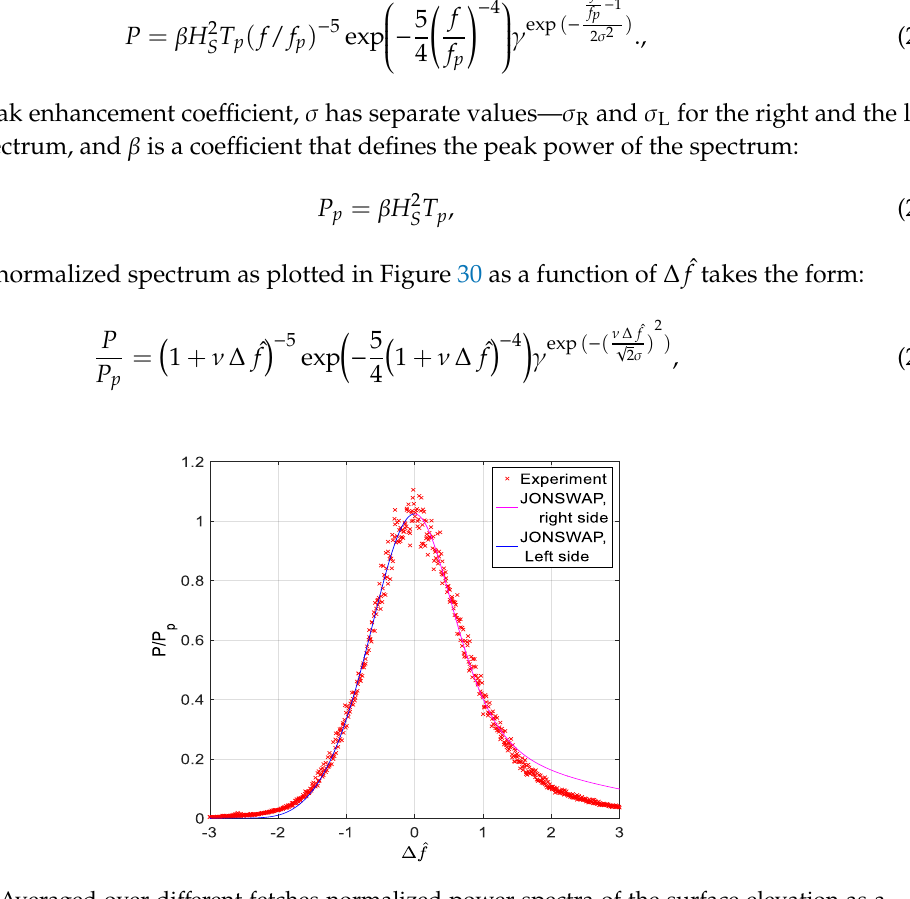
Figure 30. Averaged over different fetches normalized power spectra of the surface elevation as a function of normalized deviation from the peak frequency.